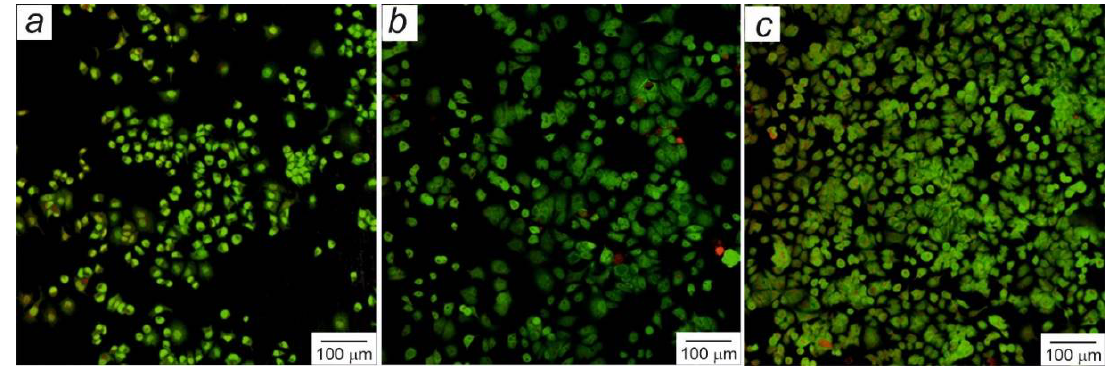
Figure 4. Confocal laser microscopy of samples after 72 h culture with MCF-7 cells: uncoated TiNi substrate ( a ), coating synthesized in an argon atmosphere ( b ), coating synthesized in a nitrogen atmosphere ( c ).